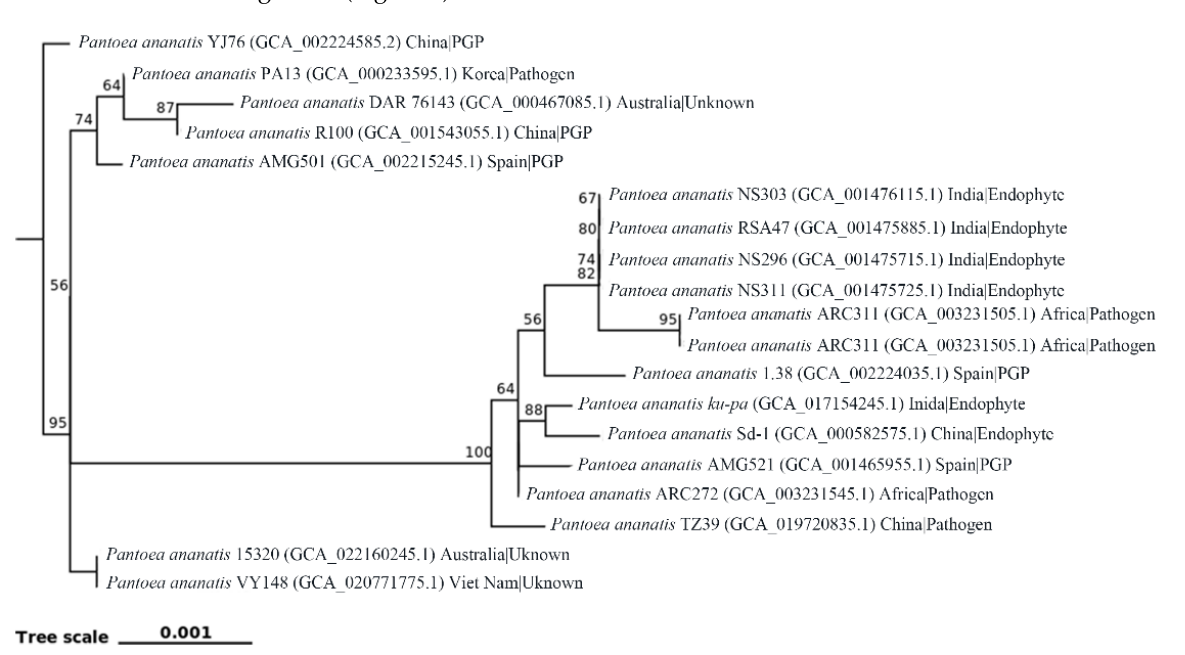
Figure 3. Phylogeny tree of P. ananatis strains associated with rice plants based on 120 core genes using maximum composite likelihood. Nodes show the result of 1000 bootstrap replicates by IQ- TREE. Trees and dendrograms were visualized using ggtree and iTOL. PGP: Plant growth promo- tion.